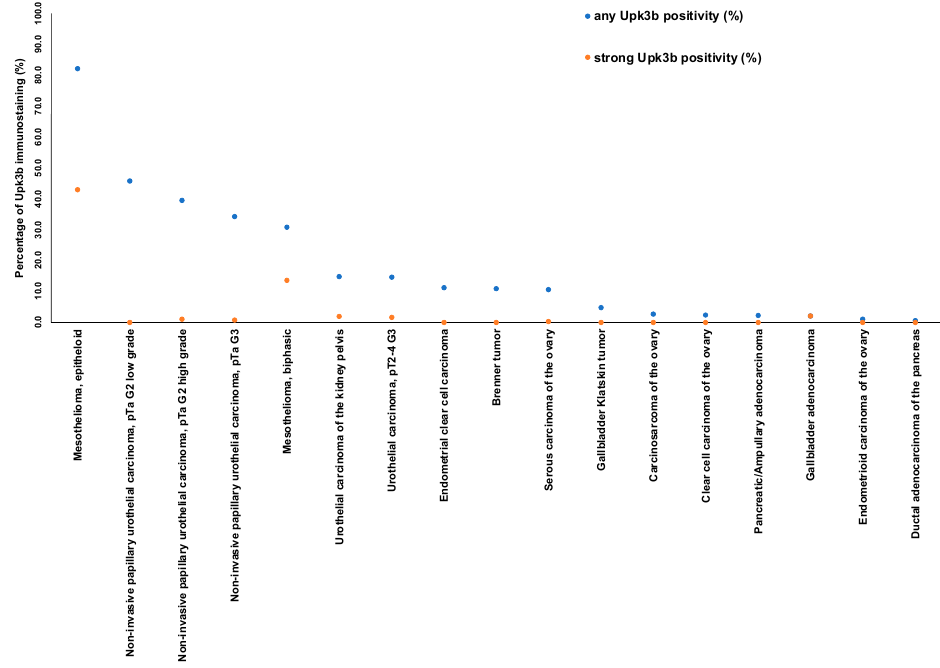
Figure 3. Examples of Upk3b immunostaining in selected cancers . The panels show a strong mem- branous Upk3b staining in samples of two epithelioid mesotheliomas ( A , B ), and a muscle-invasive urothelial carcinoma of the urinary bladder ( C ). Upk3b staining is more focal and predominantly seen on surface membranes in a serous high-grade ovarian carcinoma ( D ) and an invasive micropapillary urothelial cancer ( E ). Upk3b staining is absent in an adenocarcinoma of the lung ( F ).